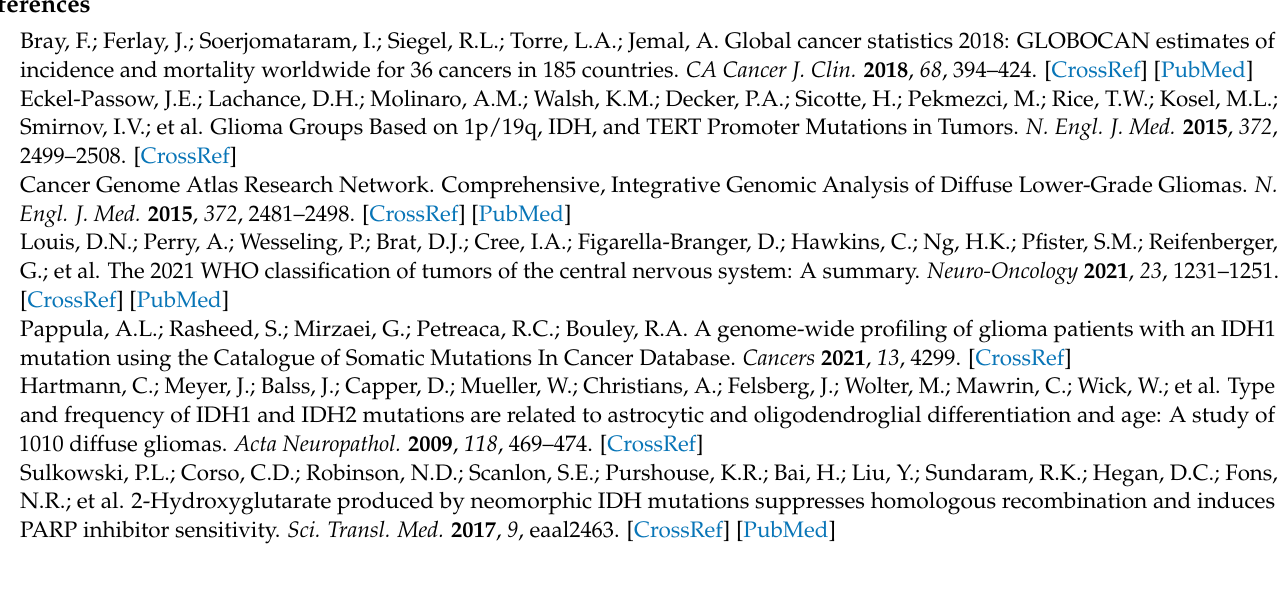
Table S1: Supplementary Material NGS, and Table S2: Supplementary Material